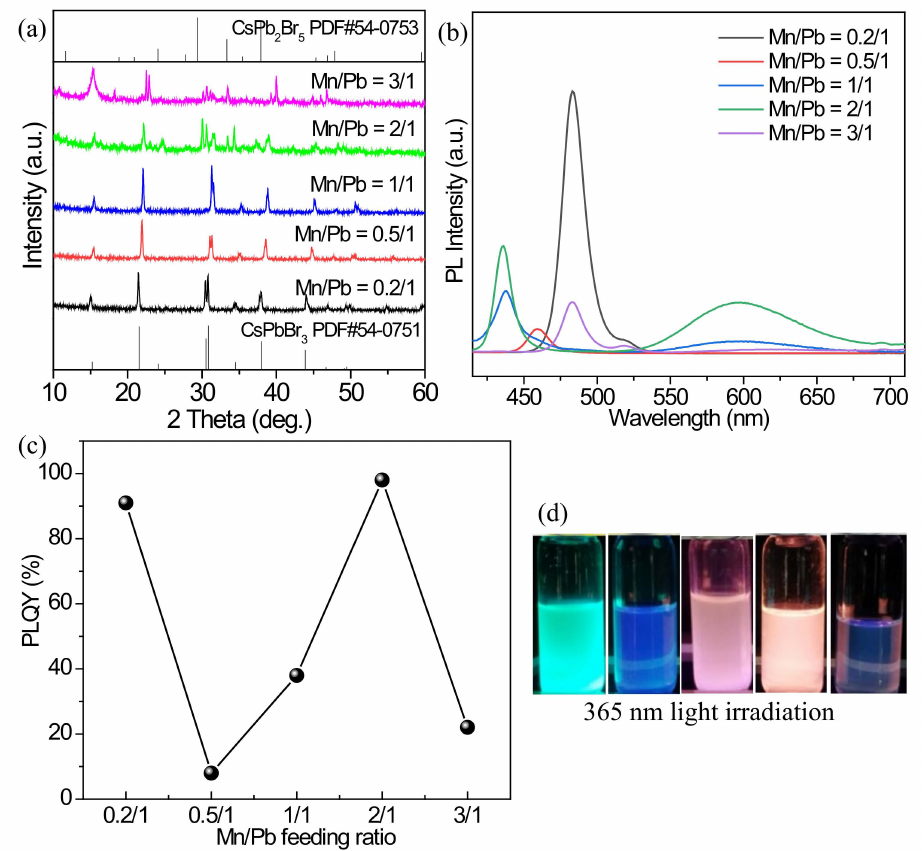
Figure 4. ( a ) XRD patterns, ( b ) PL emission spectra, and ( c ) PLQYs of the Mn 2+ -doped products fabricated with different Mn 2+ /Pb 2+ feeding ratios. ( d ) Optical images of the cyclohexane solutions containing the Mn 2+ -doped products under the environments of natural and 365 nm light: from left to right, the Mn 2+ /Pb 2+ feeding ratios are 0.2/1, 0.5/1, 1/1, 2/1, and 3/1,